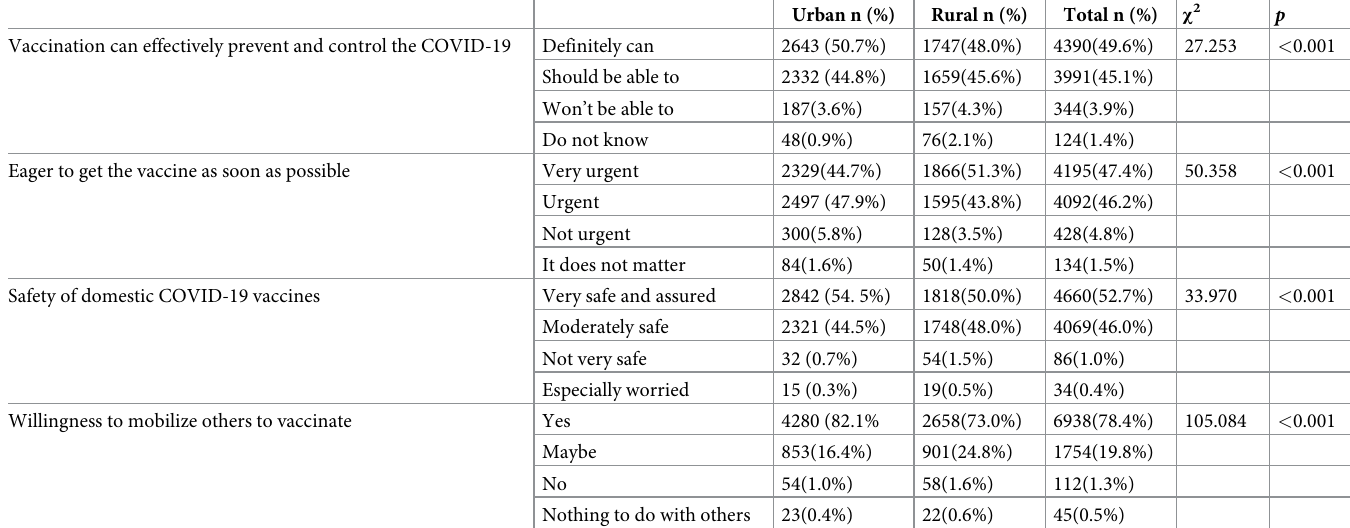
Table 3. Comparison of the differences in cognition of COVID-19 vaccination among urban and rural residents at the border (n =